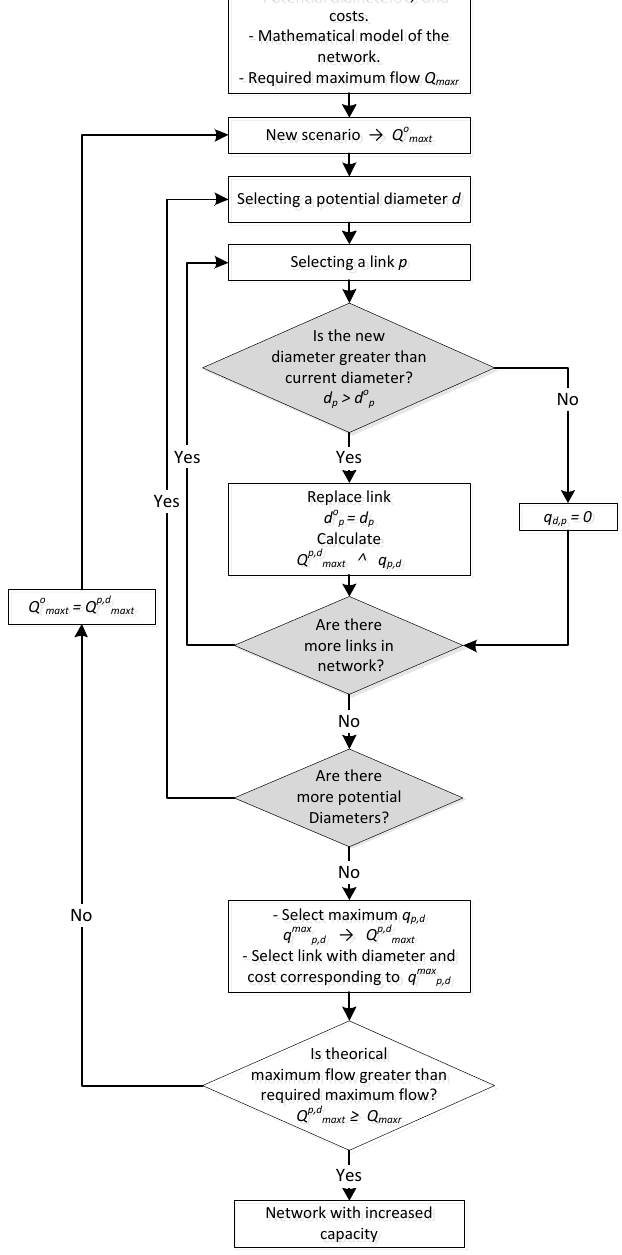
Figure 6. Flowchart for the process of increasing the network capacity.